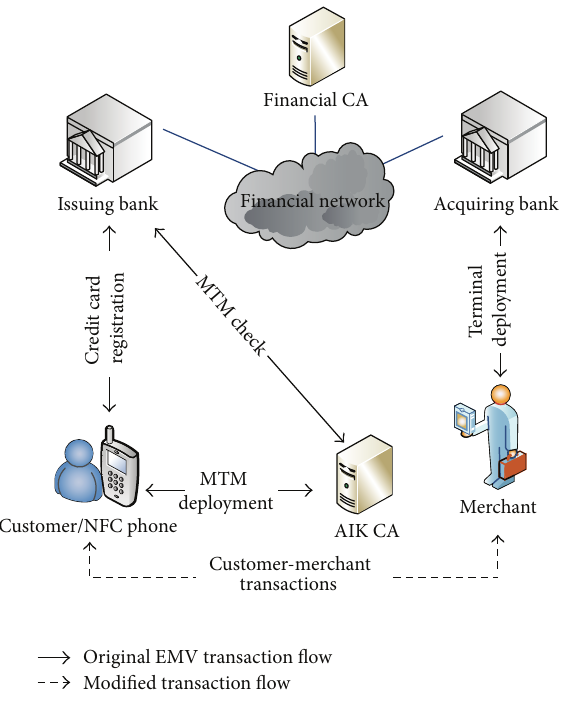
Figure 1: Our credit card transaction infrastructure.